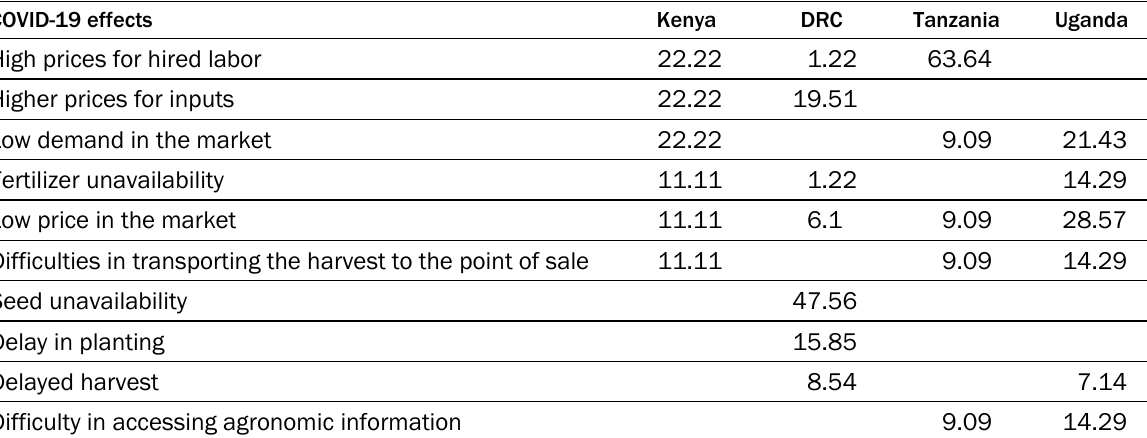
Table 1. COVID-19 Effects Disaggregated by Country, Eastern Africa COVID-19